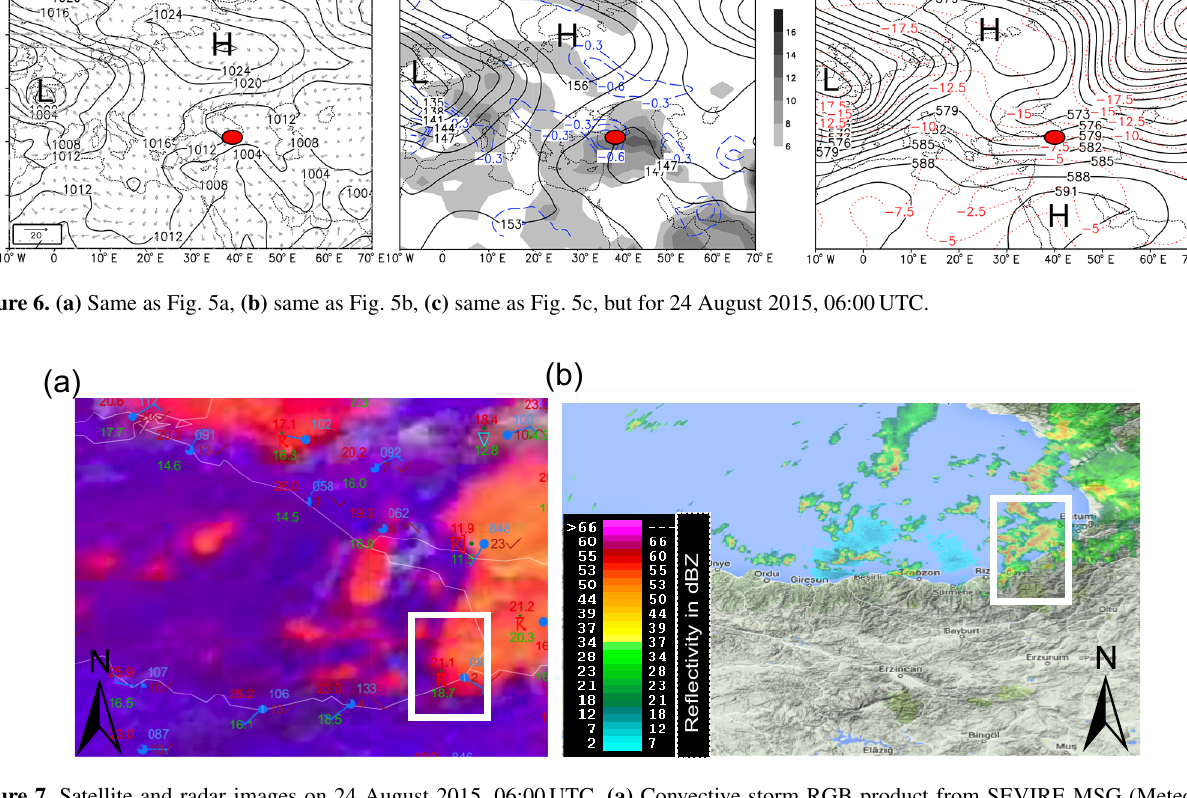
Figure 7. Satellite and radar images on 24 August 2015, 06:00UTC. (a) Convective storm RGB product from SEVIRE MSG (Meteosat Second Generation) together with SYNOP observations. (b) Radar PPI (Plan Position Indicator) image of the EBS region. Sources: (a) EUMETRAIN (http://www.eumetrain.org/), (b) Turkish State Meteorological Service